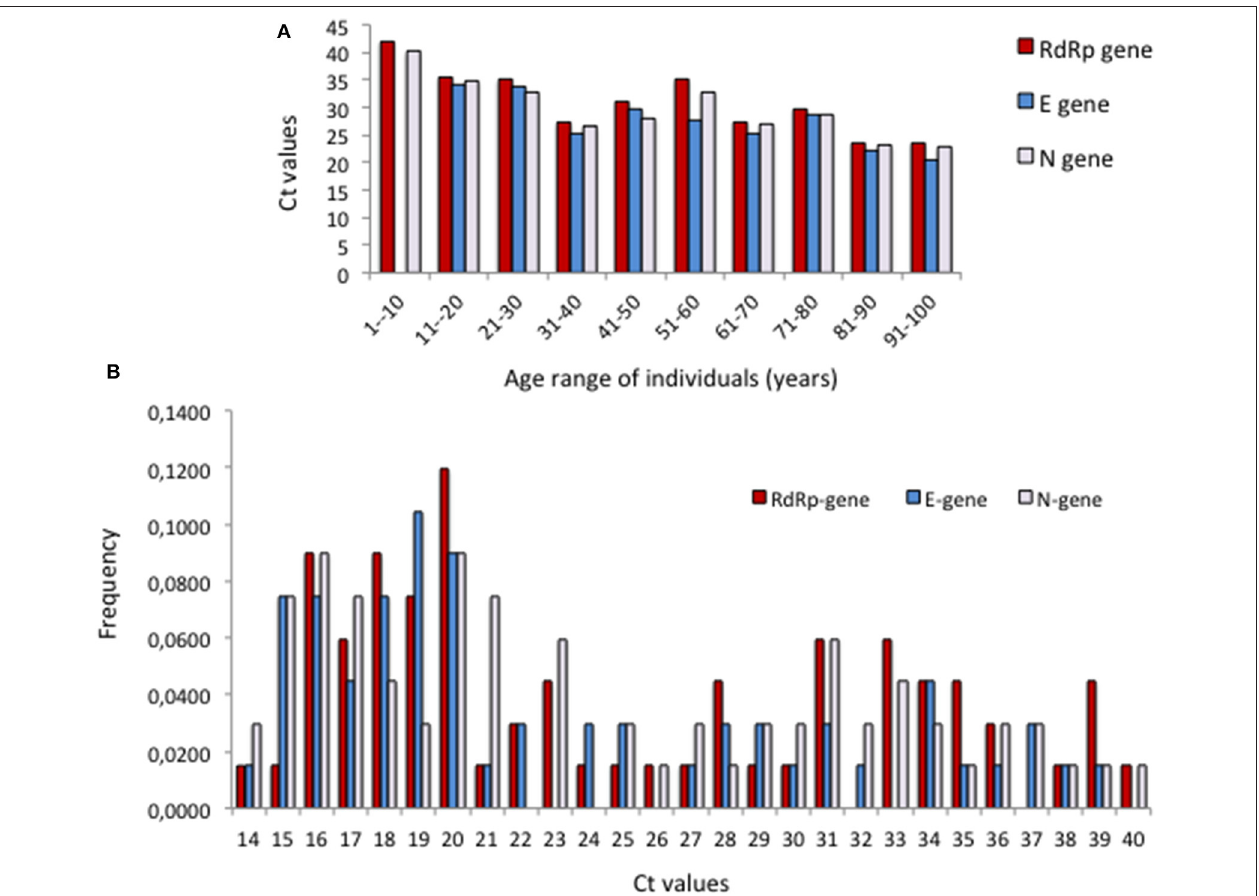
FIGURE 5 | Distribution of Ct values in the clinical samples from asymptomatic individuals. (A) Cts according to age for the 10 cohorts between ages 1 and < 100 years. (B) Frequencies of Cts in the age group 70–100